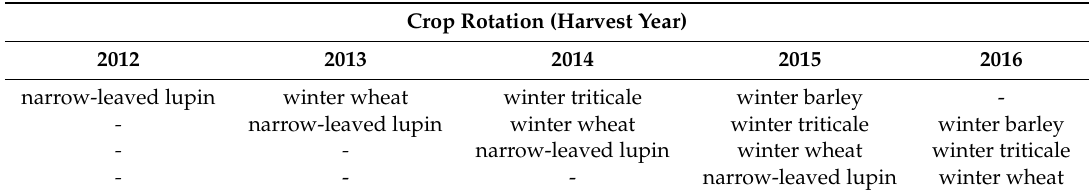
Table 2. Crop rotation in 2012–2016.